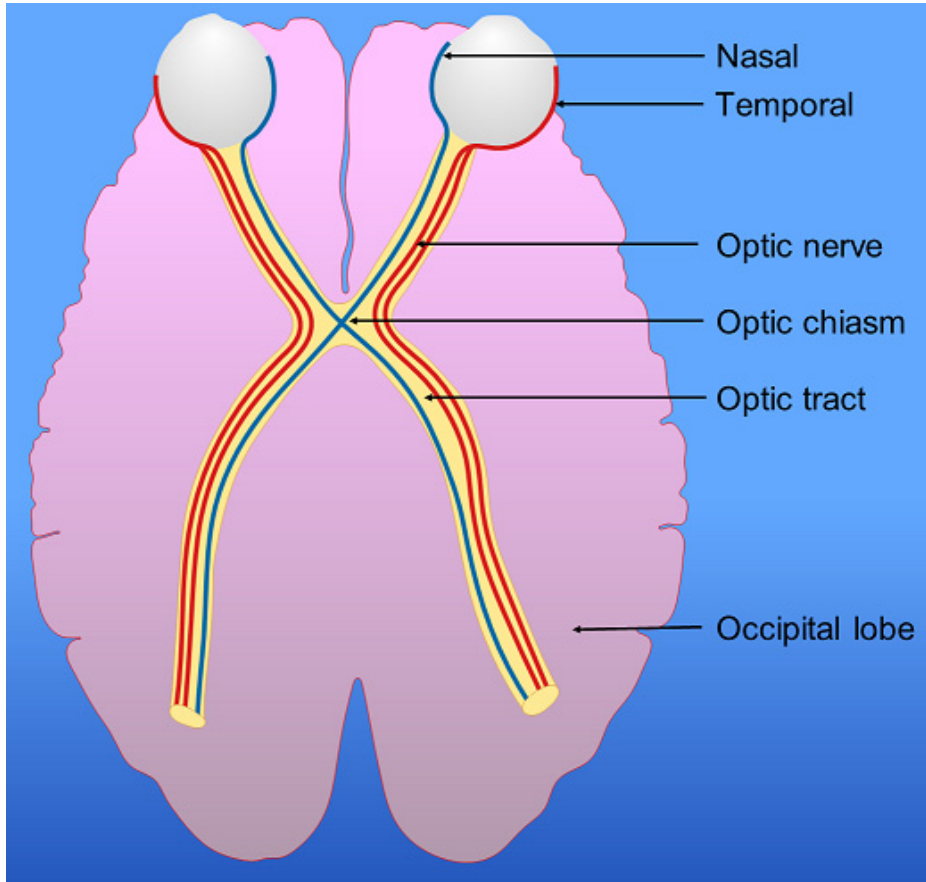
Figure 2. The visual pathway. The optic nerves from each eye partially cross at the optic chiasm so that fibers from the nasal half of each retina cross over to the contralateral optic tract. Fibers from the temporal portion of each retina remain ipsilateral. As a result, the left optic tract contains fibers originating from the left temporal retina, and the right nasal retina while the right optic tract contains fibers originating from the right temporal retina, and the left nasal retina.